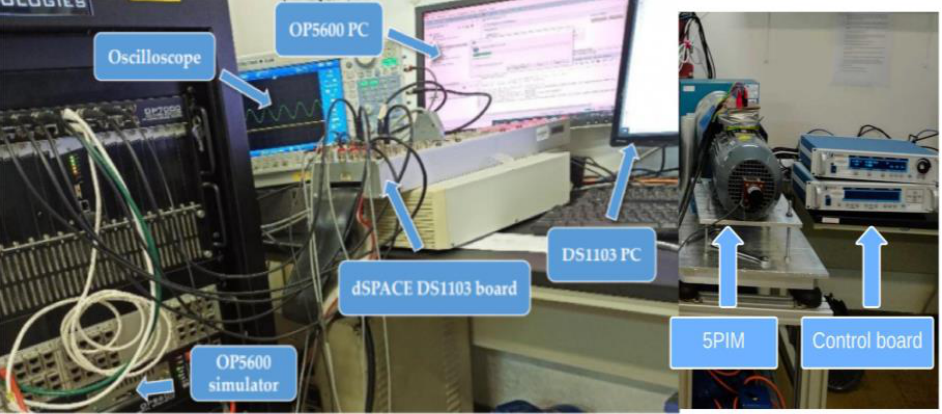
Figure 4. Hardware-in-the-loop setup.